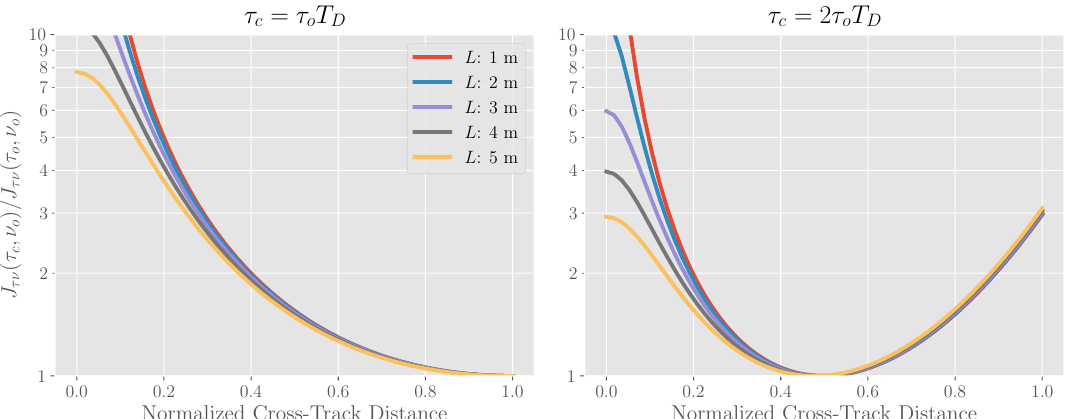
Figure 5. Degradation in performance in J τν for fixed PRF relative to the value where the PRF is allowed to vary as a function of scan angle for varying antenna length L . On the left panel, the PRF is optimized for broadside viewing (e.g., as in SKIM), while, on the right, it is optimized to have lowest error in the mid-swath. As can be seem, performance can degrade by close to an order of magnitude for the worst scan angles if the PRF is not varied over the scan. A temporal correlation time of 1ms was used for these